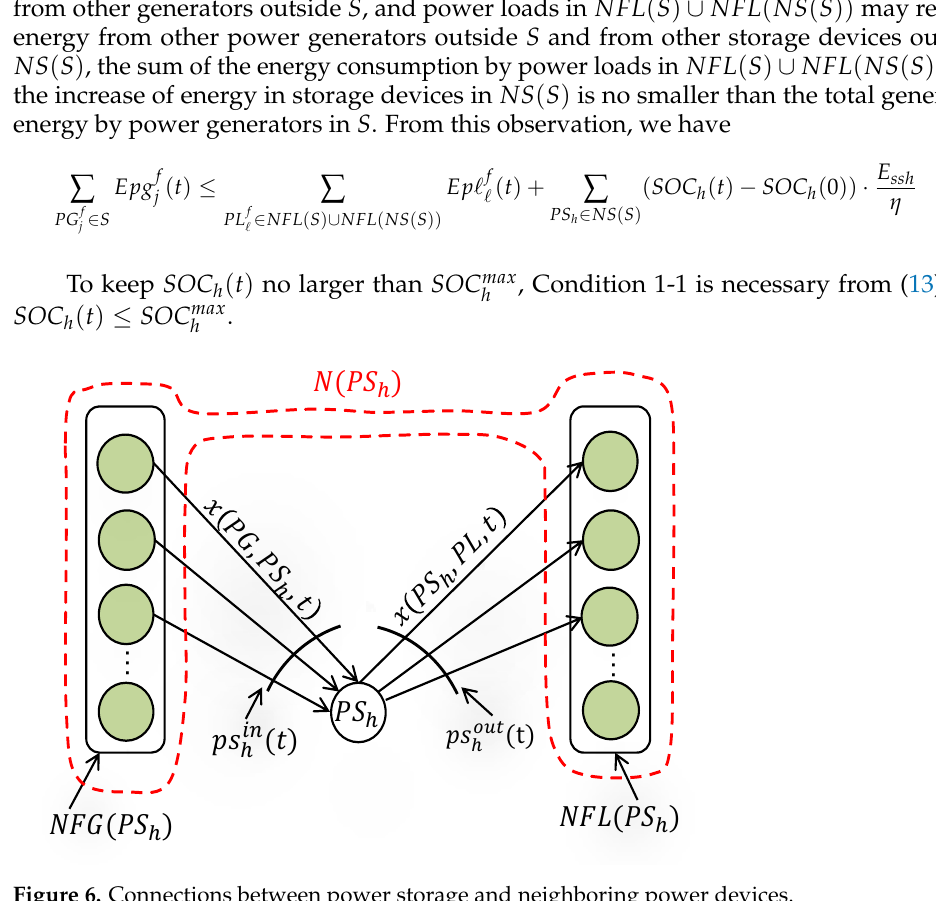
Figure 6. Connections between power storage and neighboring power